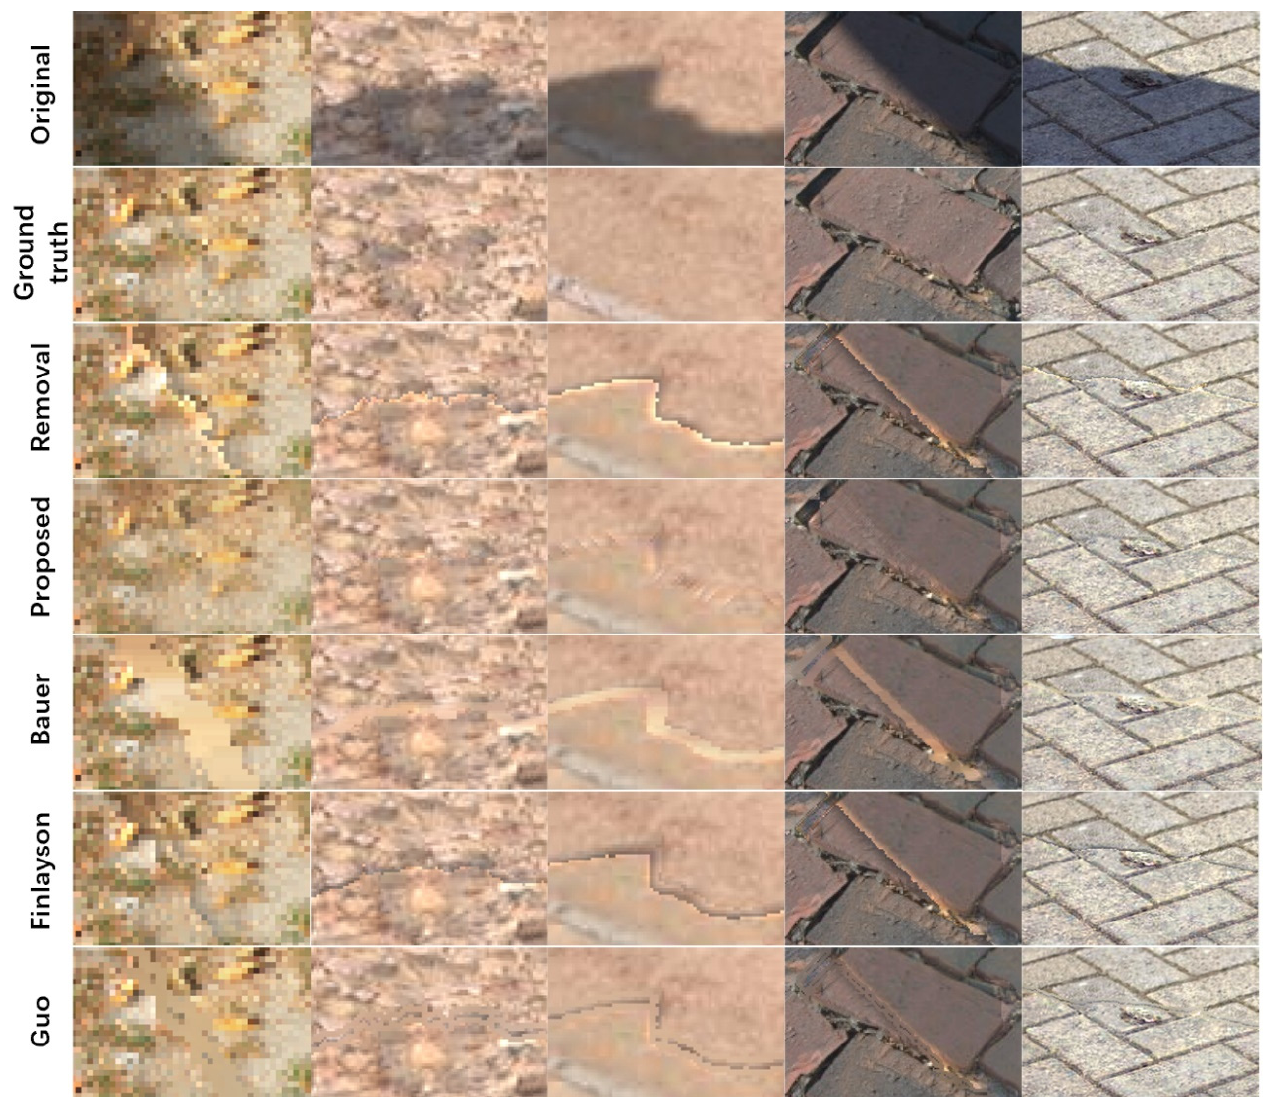
Figure 20. Details of the penumbra removal methods. The first row is the original images; the second row is the ground truth; the third row is the results without penumbra removal; the fourth row is the results of the proposed method; the fifth row is the results of Bauer’s method; the sixth row is the results of Finlayson’s method; and the seventh row is the results of Guo’s method.